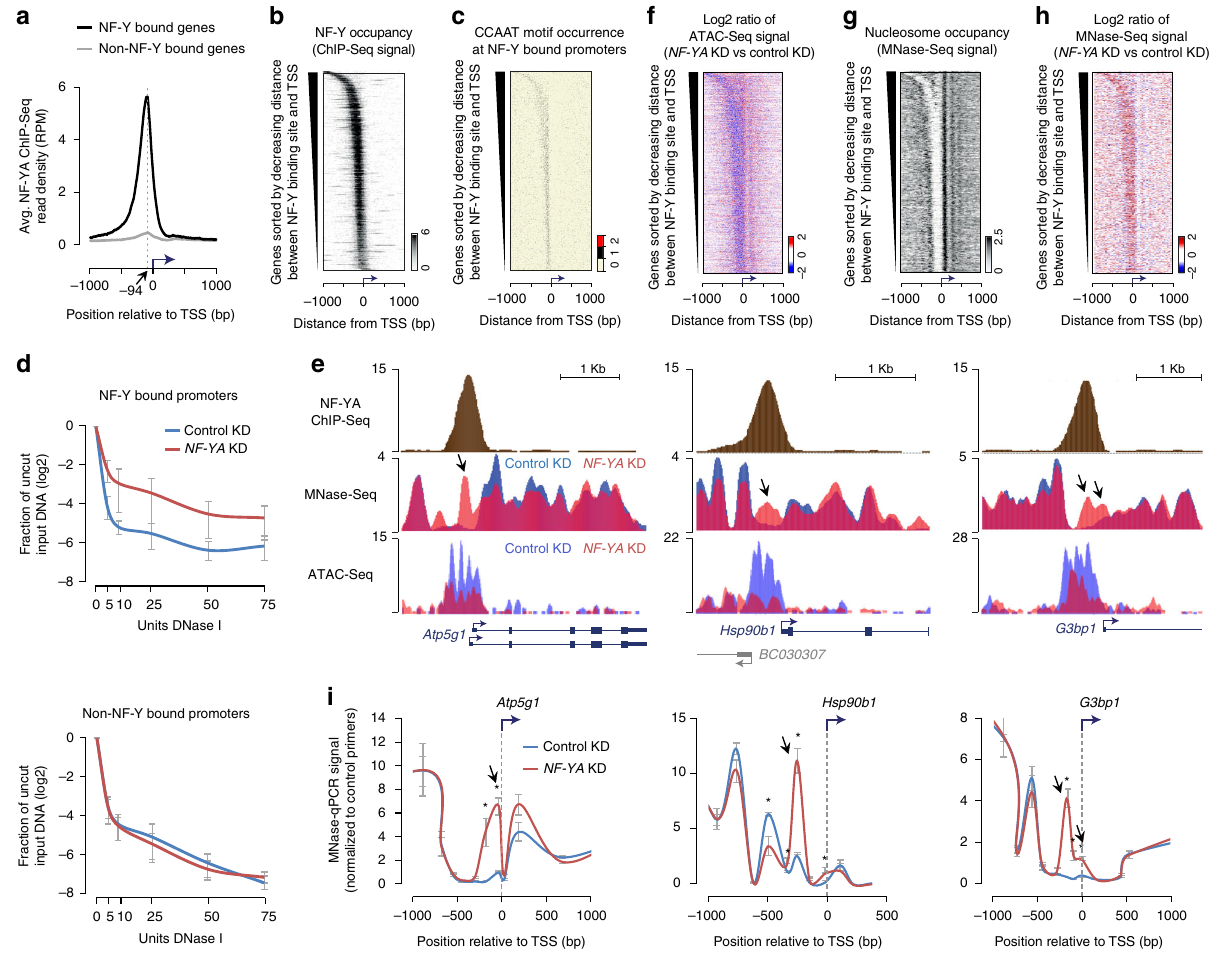
Fig. 1 NF-Y binding at gene promoters protects the nucleosome-depleted region (NDR) from nucleosome encroachment. a Average NF-YA occupancy ( y -axis), as measured using ChIP-Seq, near transcription start sites (TSSs) of genes with (black, n = 3191) or without (gray, n = 21,195) promoter-proximal NF-Y binding in mouse ESCs. RPM, reads per million mapped reads. b NF-YA occupancy near TSSs of genes with promoter-proximal NF-Y binding. c CCAAT motif occurrence near TSSs of genes with promoter-proximal NF-Y binding. d DNase I hypersensitivity and qPCR analysis of promoters with (top; n = 6) or without (bottom; n = 4) NF-Y binding in control (blue) and NF-YA KD (red) ESCs. Error bars, SEM. The data for individual promoters shown in Supplementary Fig. 1f, g. e Genome browser shots of candidate NF-Y target genes showing nucleosome occupancy in control (blue) or NF-YA KD (red) ESCs. Gene structure is shown at the bottom. Arrows highlight nucleosomal gain in NF-YA KD cells over what was previously a well-de fi ned NDR in control KD cells. f Relative change (log2) in chromatin accessibility, as measured using ATAC-Seq, near TSSs of genes with promoter-proximal NF-Y binding in NF-YA KD vs. control KD ESCs. g Nucleosome occupancy (RPKM), as measured using MNase-Seq, near TSSs of genes with promoter-proximal